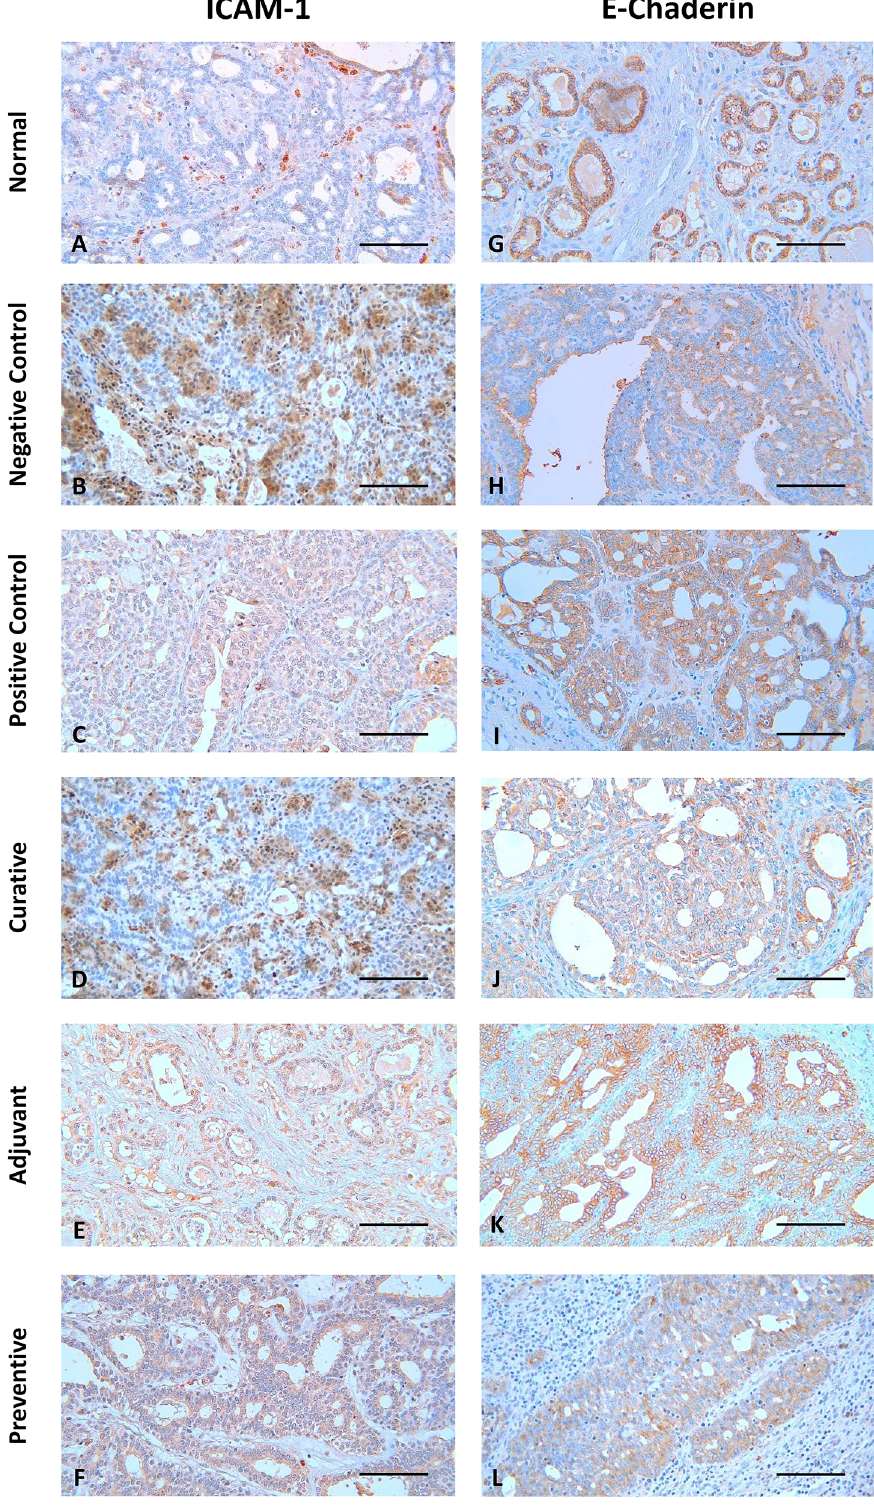
Figure 1. Representative image of immunohistochemistry staining for ICAM-1 and E-Cadherin in mouse breast tissue. Scale bar represents 50 μ m. All images were taken at 400 (cid:1)